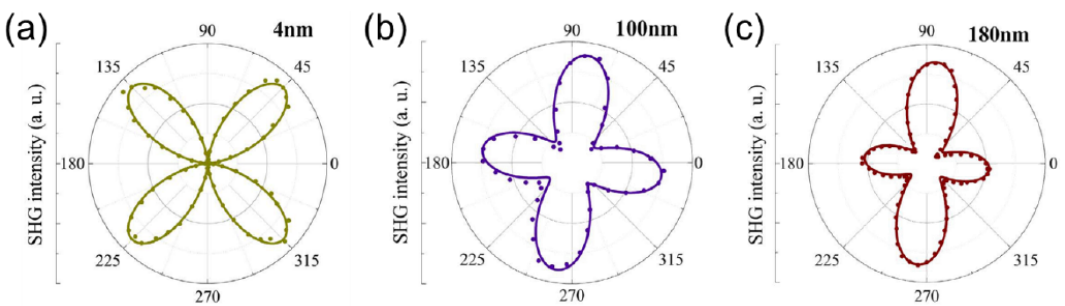
Figure 11. SHG to probe strain relaxation. ( a – c ) Polarizer measurements for different BFO film thicknesses can quantify the amount of T- and R-phases associated with a certain thickness. Reprinted from